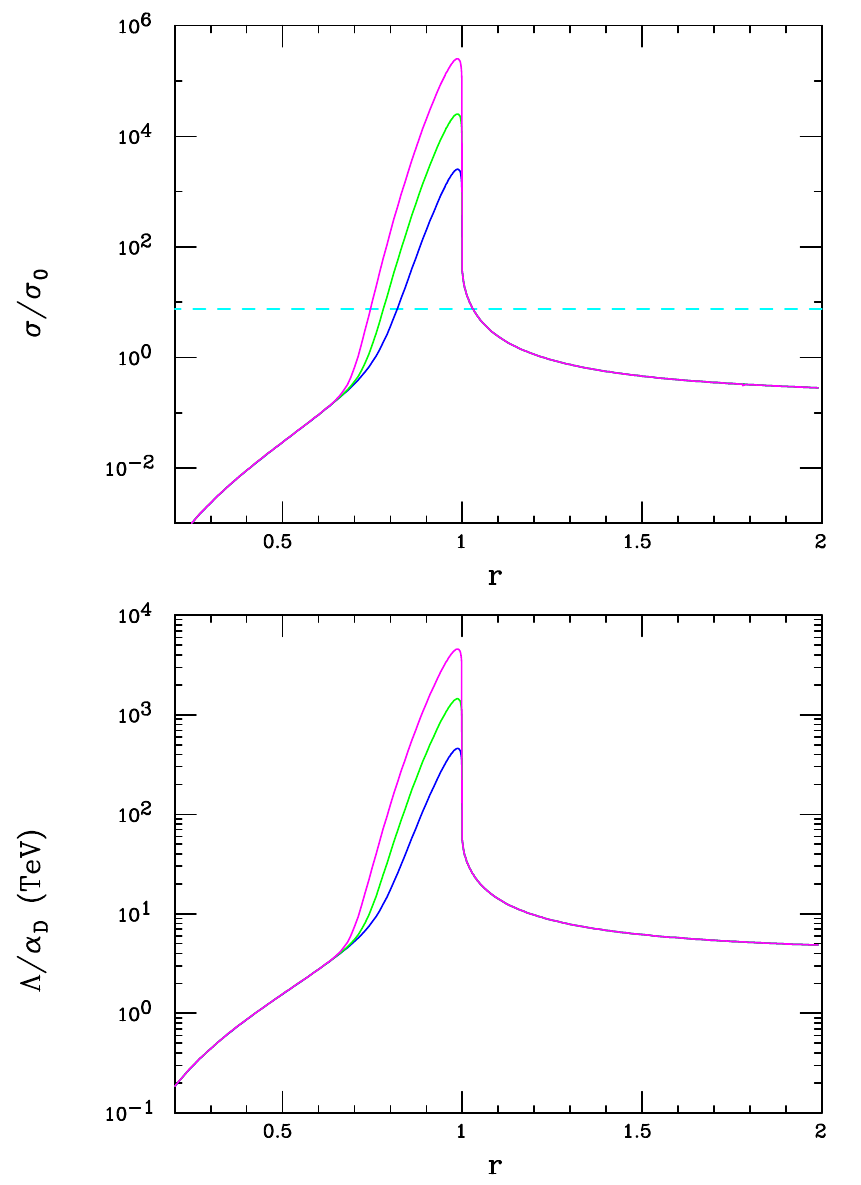
Figure 3 . (Top) DM annihilation cross section into the e + e − final state as a function of r in units of σ 0 assuming that (cid:15) = 0 , x F = 20 , F = 1 , and Λ e /α D = 25 TeV for purposes of demonstration. The blue (green, magenta) curve corresponds to choice α D = 1(0 . 1 , 0 . 01) , respectively. The dashed cyan horizontal line corresponds to the cross section needed to reproduce the observed relic density. (Bottom) The value of Λ e /α D as a function of r which reproduces the observed relic density again assuming that F = 1 as described in the